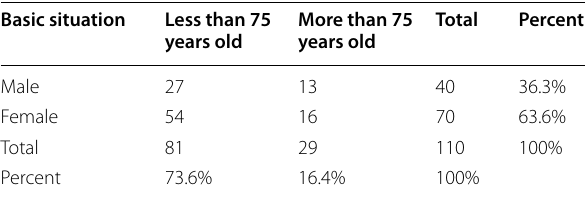
Table 2 Basic condition of the patients Basic